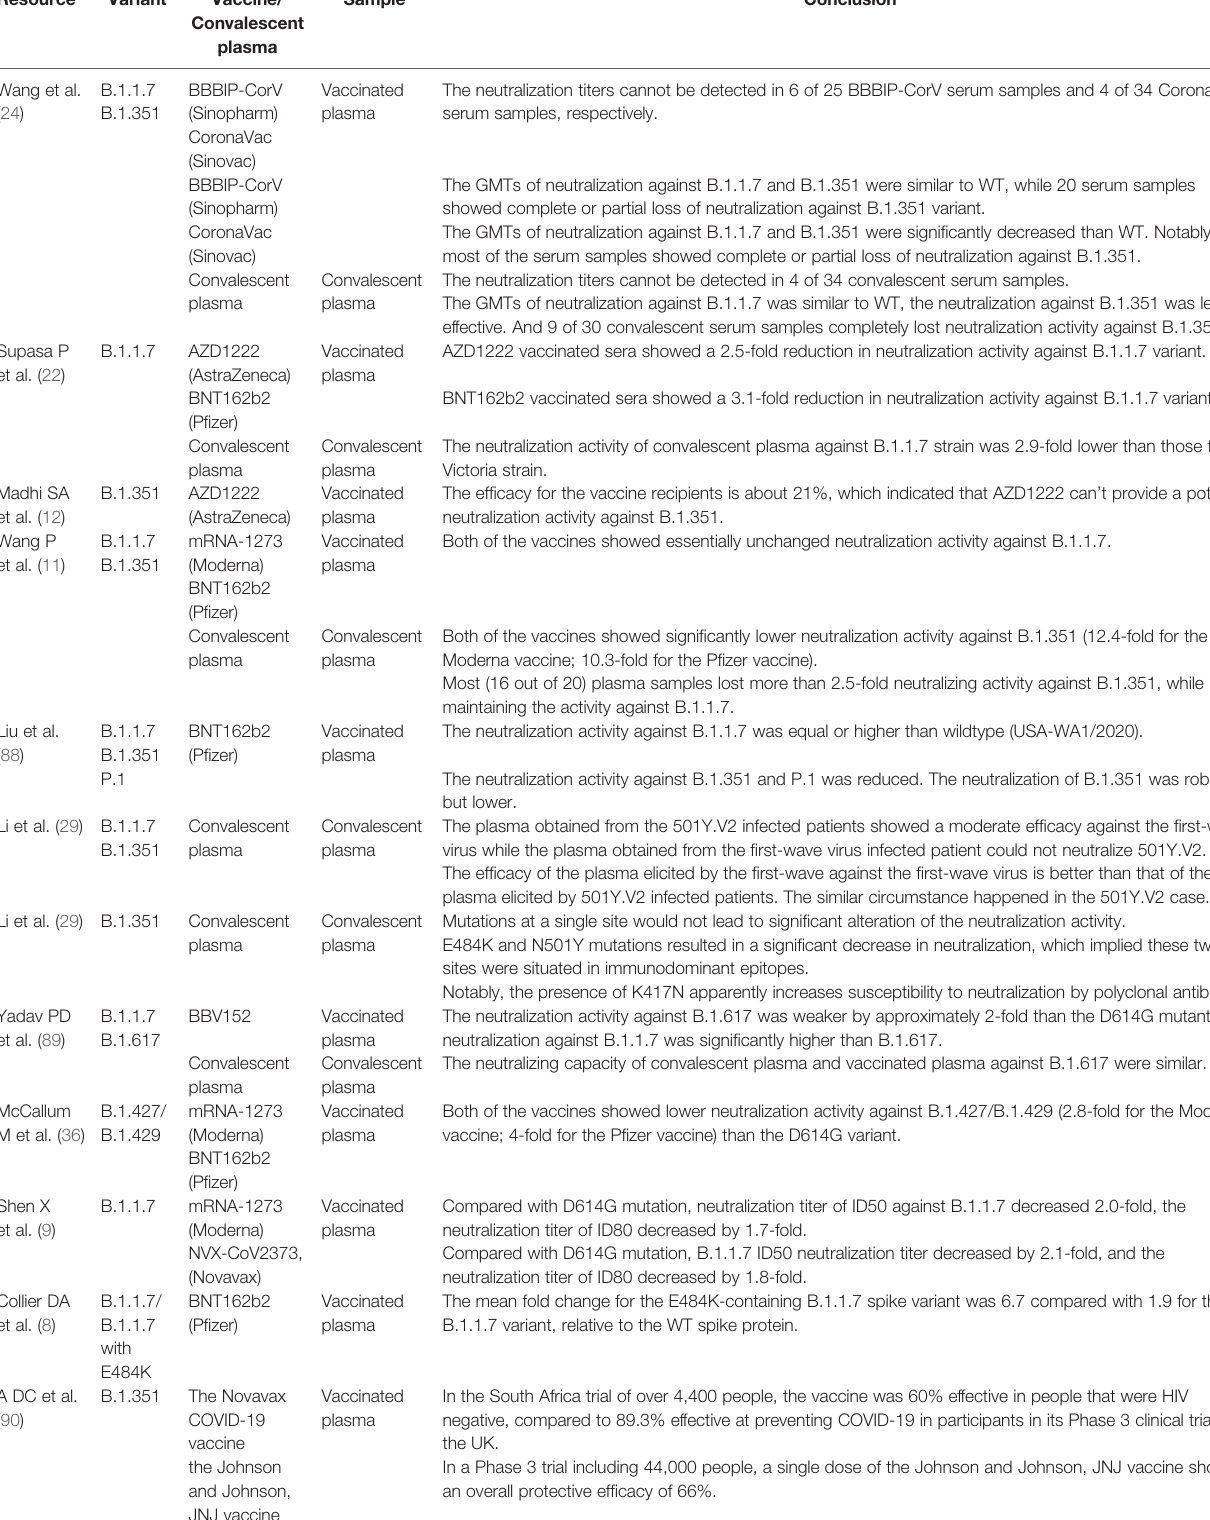
TABLE 2 | The ef fi cacy of approval vaccines against several prevalent variants.